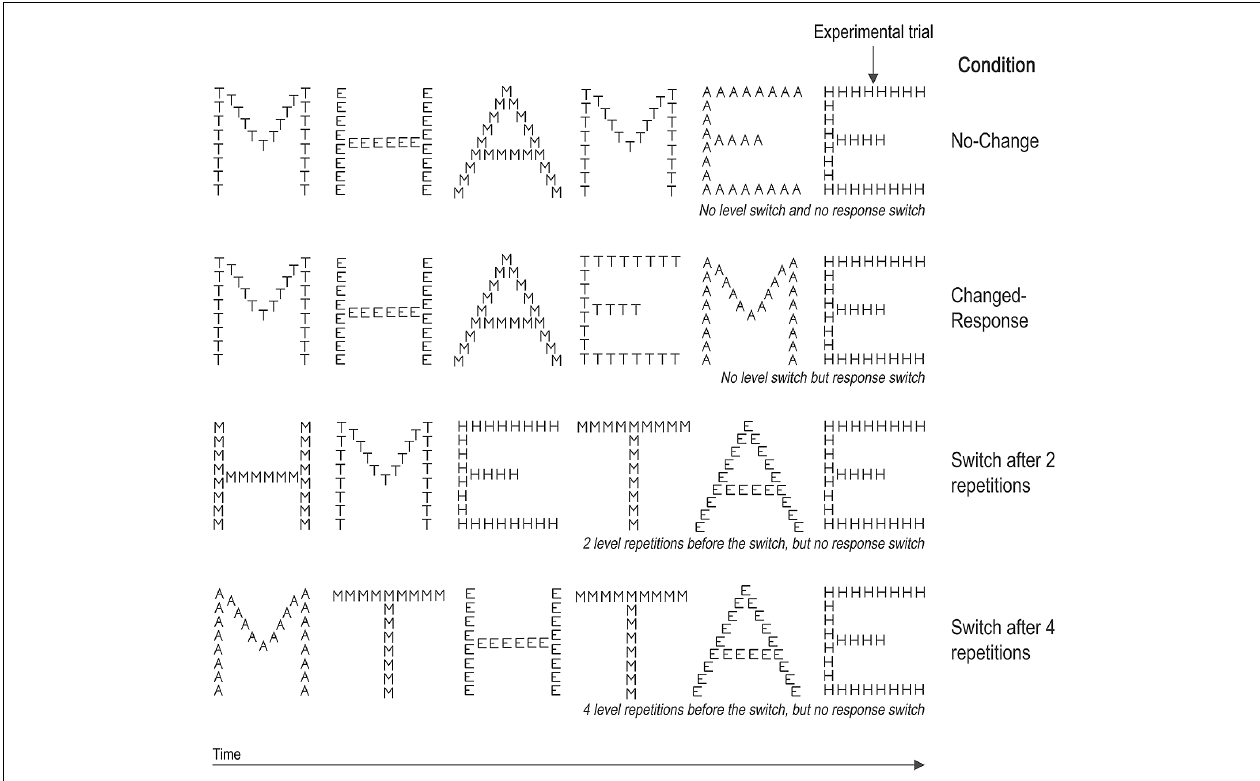
FIGURE 2 | Examples of context stimuli sequences regarding each of the context